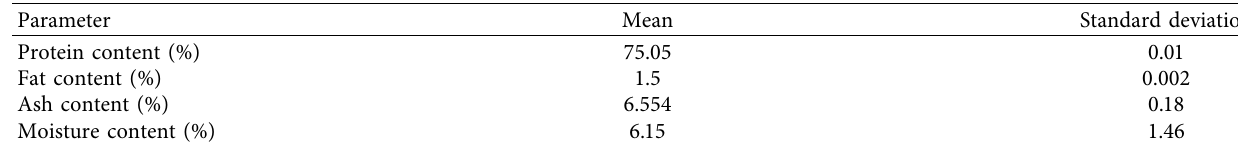
Table 2: Proximate analysis of cattle